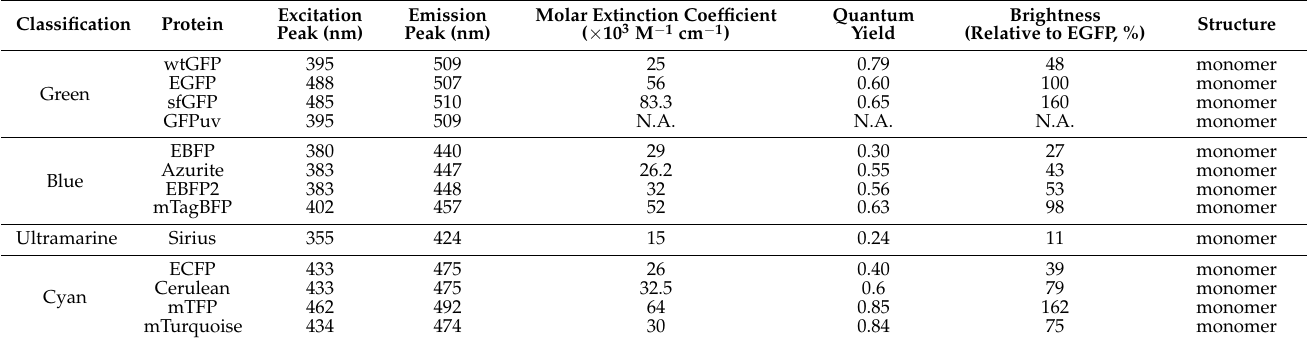
Table 1. Photophysical properties of GFP, RFP, and their